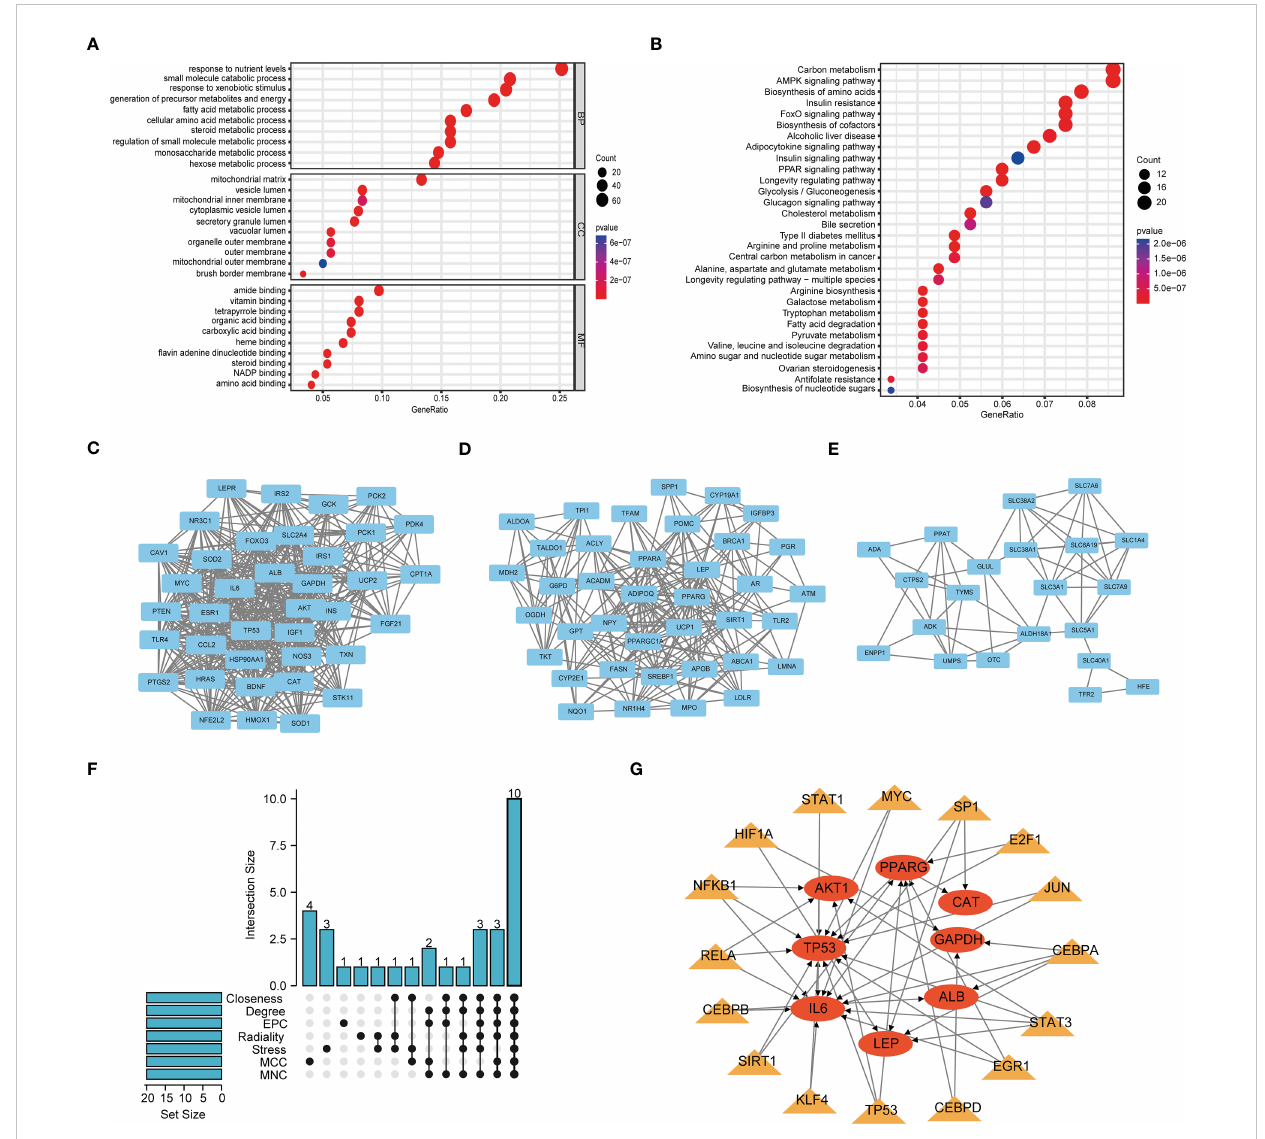
FIGURE 1 Function and subnetwork analysis of genes related to glutamine metabolism. (A) The top 10 rich terms for Biological Progress(BP), Cellular Component(CC) and Molecular Function(MF) in GO analysis. (B) The top 30 rich terms in KEGG ’ s analysis. (C – E) MCODE plug-in gets three main network modules. (F) UpSet of cytohubba plug-in seven algorithms. (G) Transcription factors predicted by TRRUST for Hub genes. Circles represent genes and triangles represent transcription